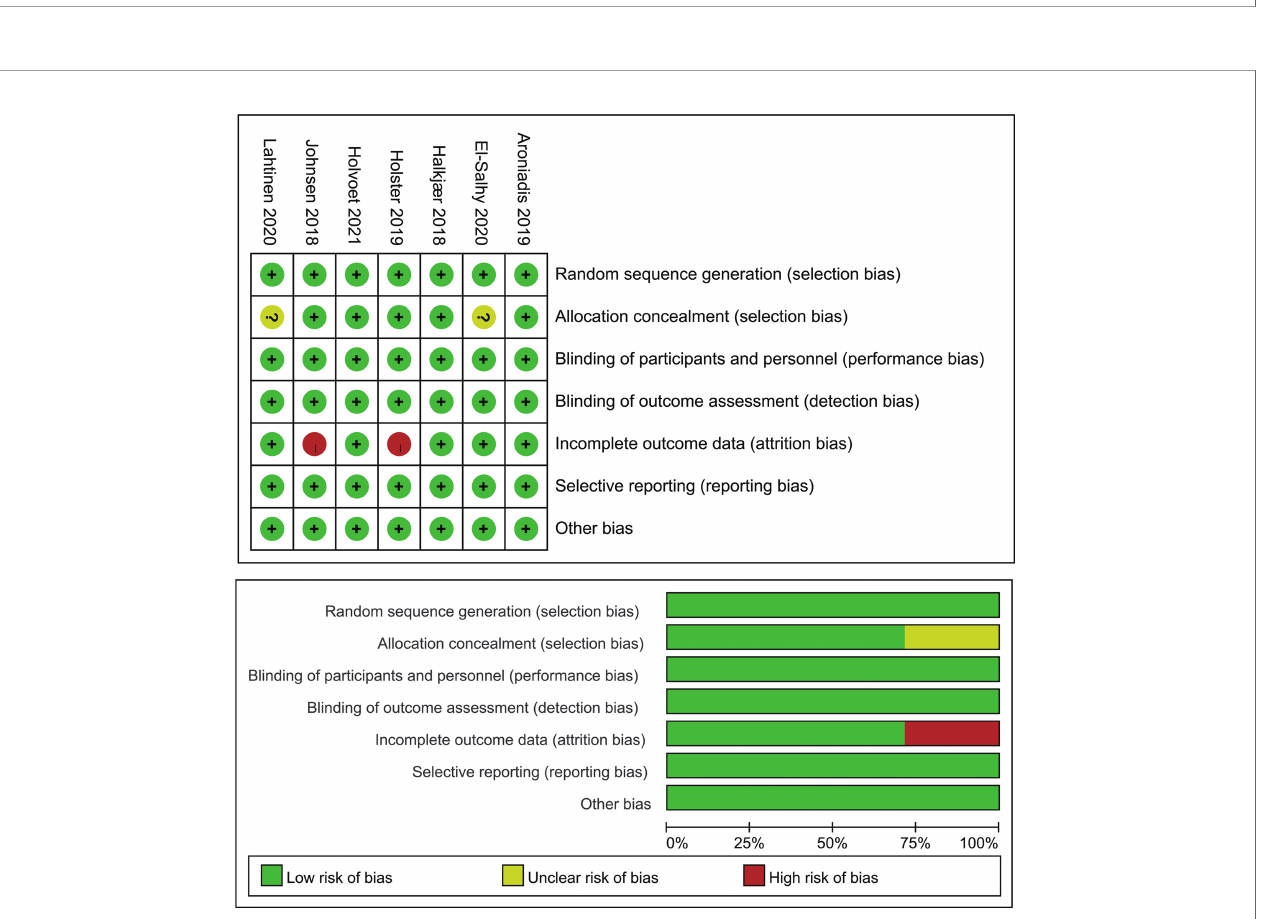
FIGURE 5 | Forest plot of all included RCTs of global symptom not improving in comparison between FMT and placebo in irritable bowel syndrome at the 1-year follow-up.